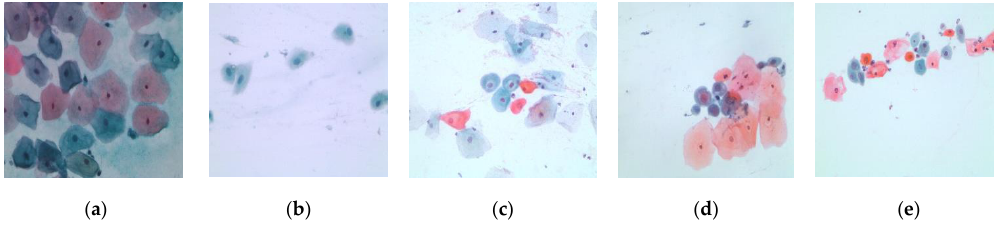
Figure 4. Multi-cells images of five classes: ( a ) Superficial-Intermediate cells, ( b ) Parabasal cells, ( c ) Metaplastic cells, ( d ) Dyskeratotic cells, and ( e ) Koilocytotic cells.